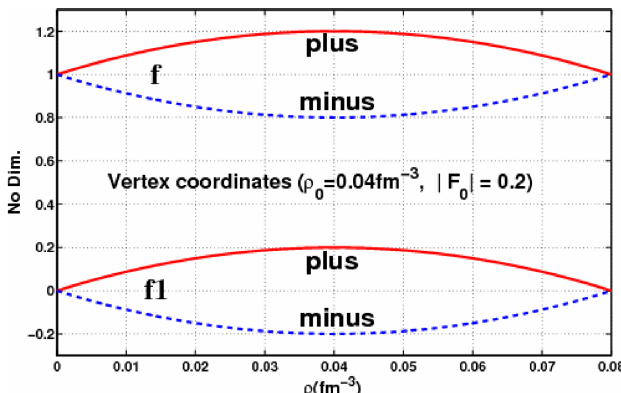
Fig. 2. The curves of perturbation function f 1 and f at r (cid:3) 0.08 fm (cid:1) 3